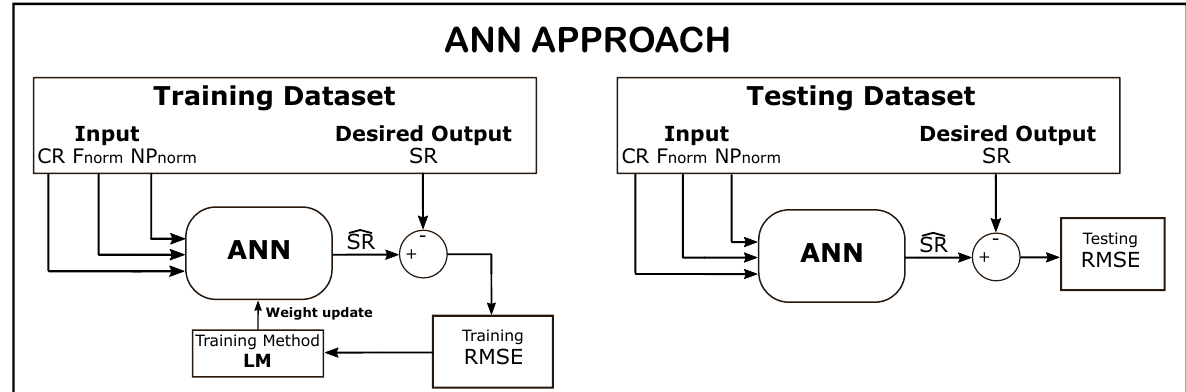
Figure 3. Schematic illustration of the proposed method’s third step, called ANN approach. The ANN approach is composed of the training and the testing processes of ANN. The left scheme defines the training of the ANN. The right scheme defines the testing of the